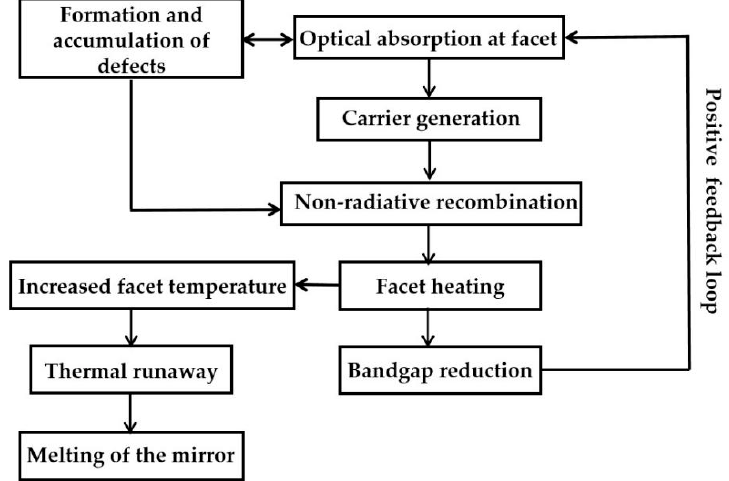
Figure 3. COMD generation